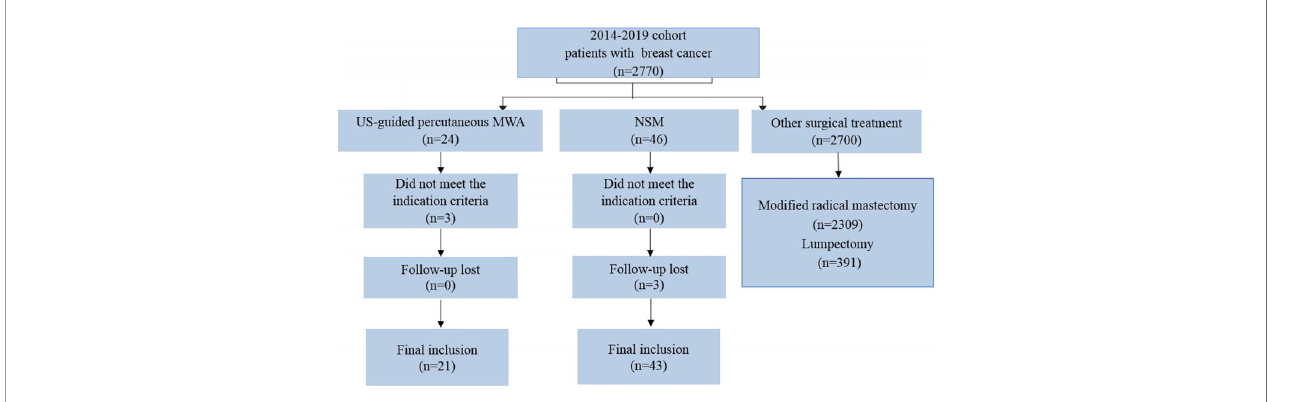
FIGURE 1 | Flow of study inclusion. A total of 2,770 patients were examined with breast cancer, and 64 patients with ≤ 5 cm tumors treated with US-guided percutaneous MWA or NSM were fi nally included. US, ultrasound; MWA, microwave ablation; NSM, nipple sparing mastectomy.